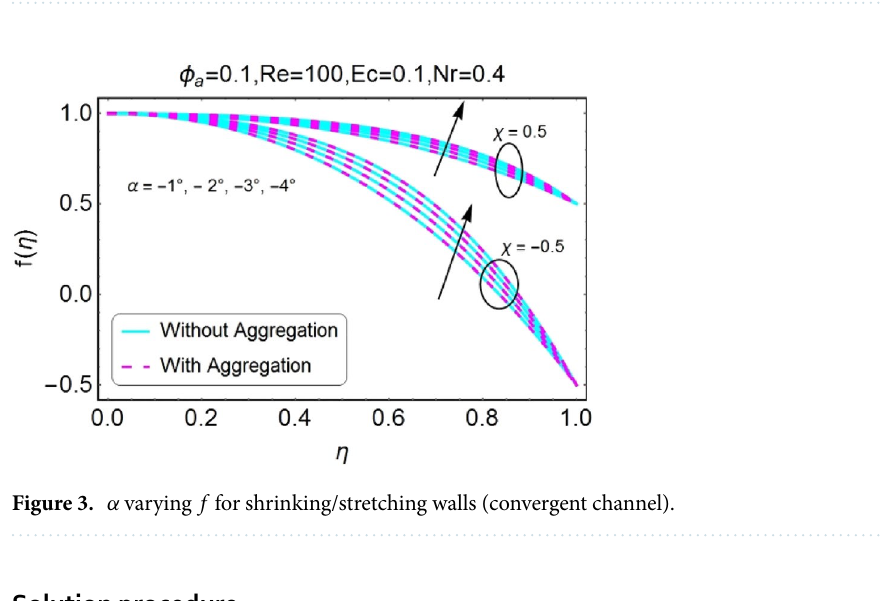
Figure 2. α varying f for shrinking/stretching walls (divergent channel).